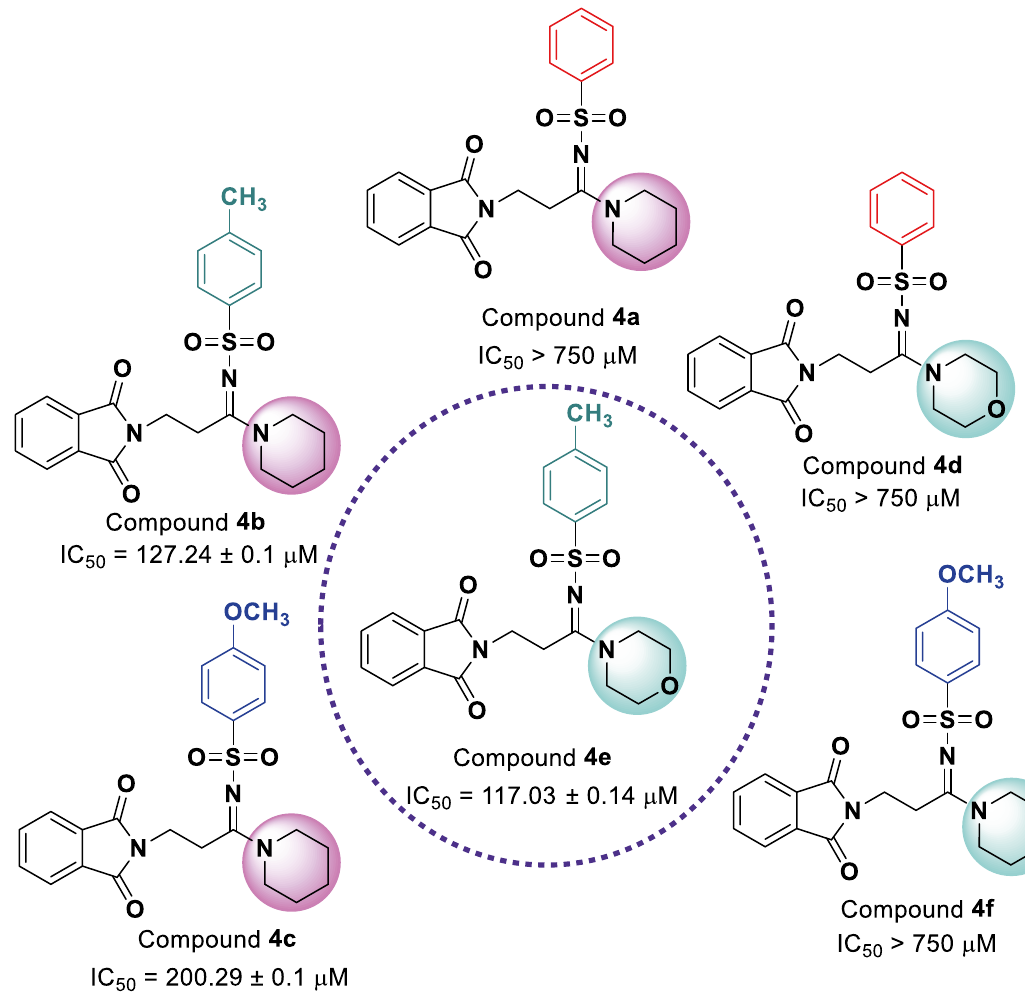
Figure 3. Comparison of α-glucosidase inhibitory activities of piperidine derivatives 4a – c with morpholine derivatives 4d – f (ChemDraw